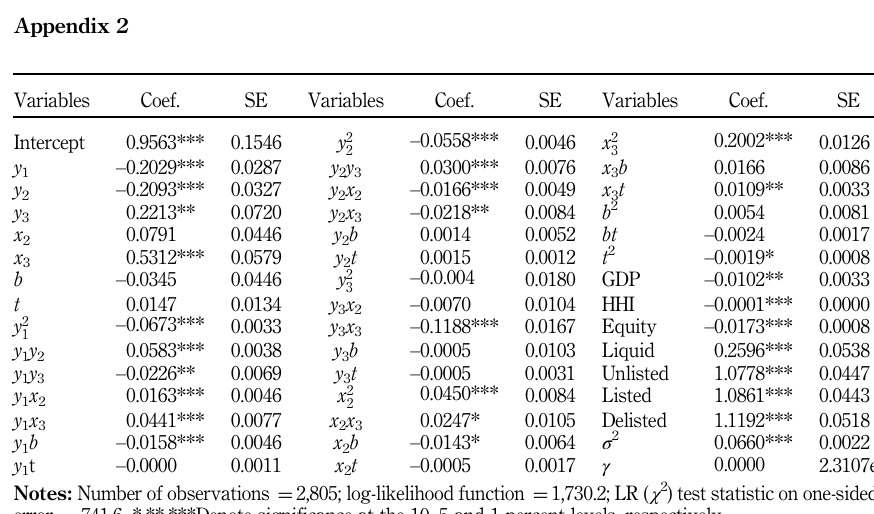
Table AII. DDF regression for both good and bad